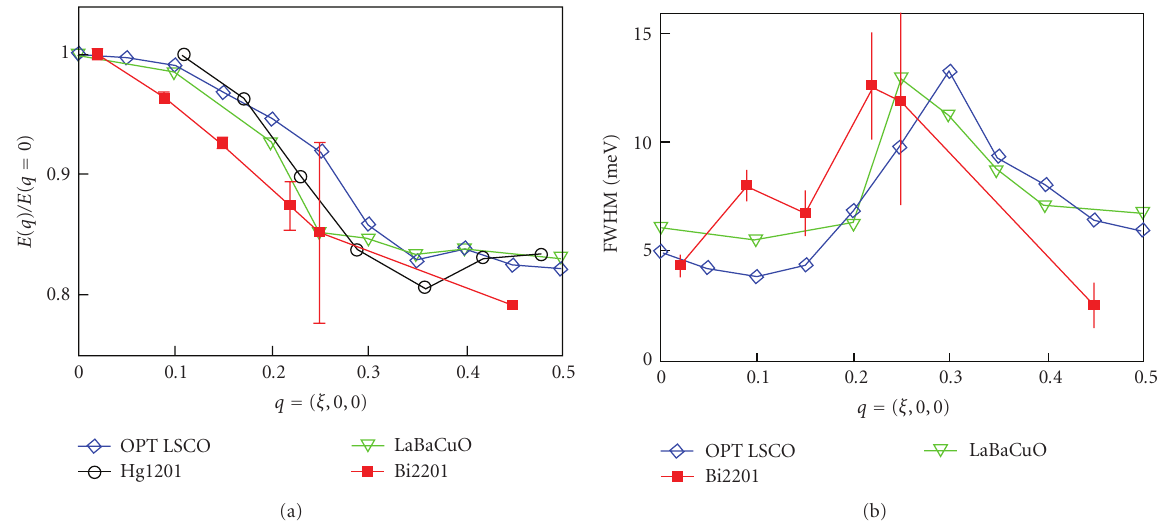
Figure 17: (a) Bond stretching mode softening in a variety of optimally hole-doped cuprates compared to the La-Bi2201 data. (b) Similar comparison of peak FWHM. The figures are from [62]. Data on LSCO and LaBaCuO come from [63] and the Hg1201 comes from [64].